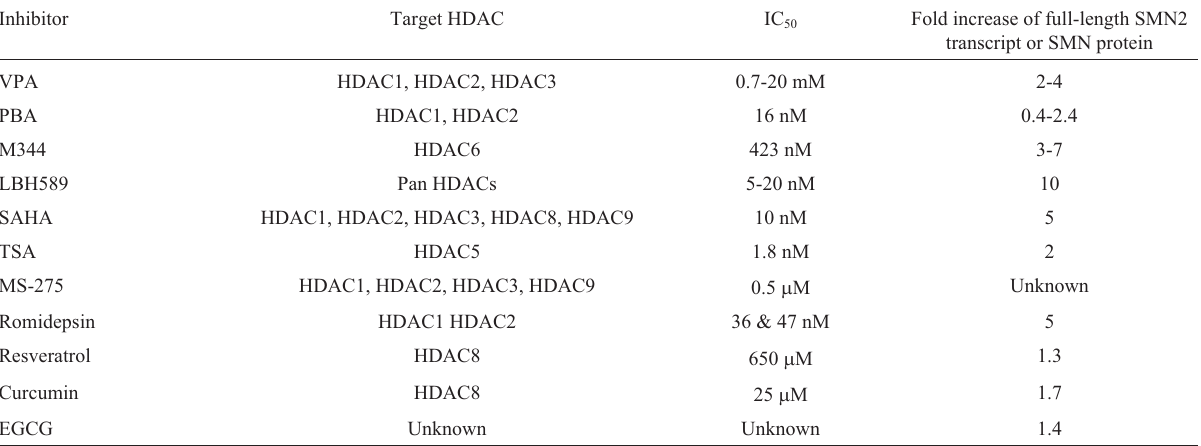
Table 1B - Histone deacetylase (HDAC) inhibitors and their target enzymes.